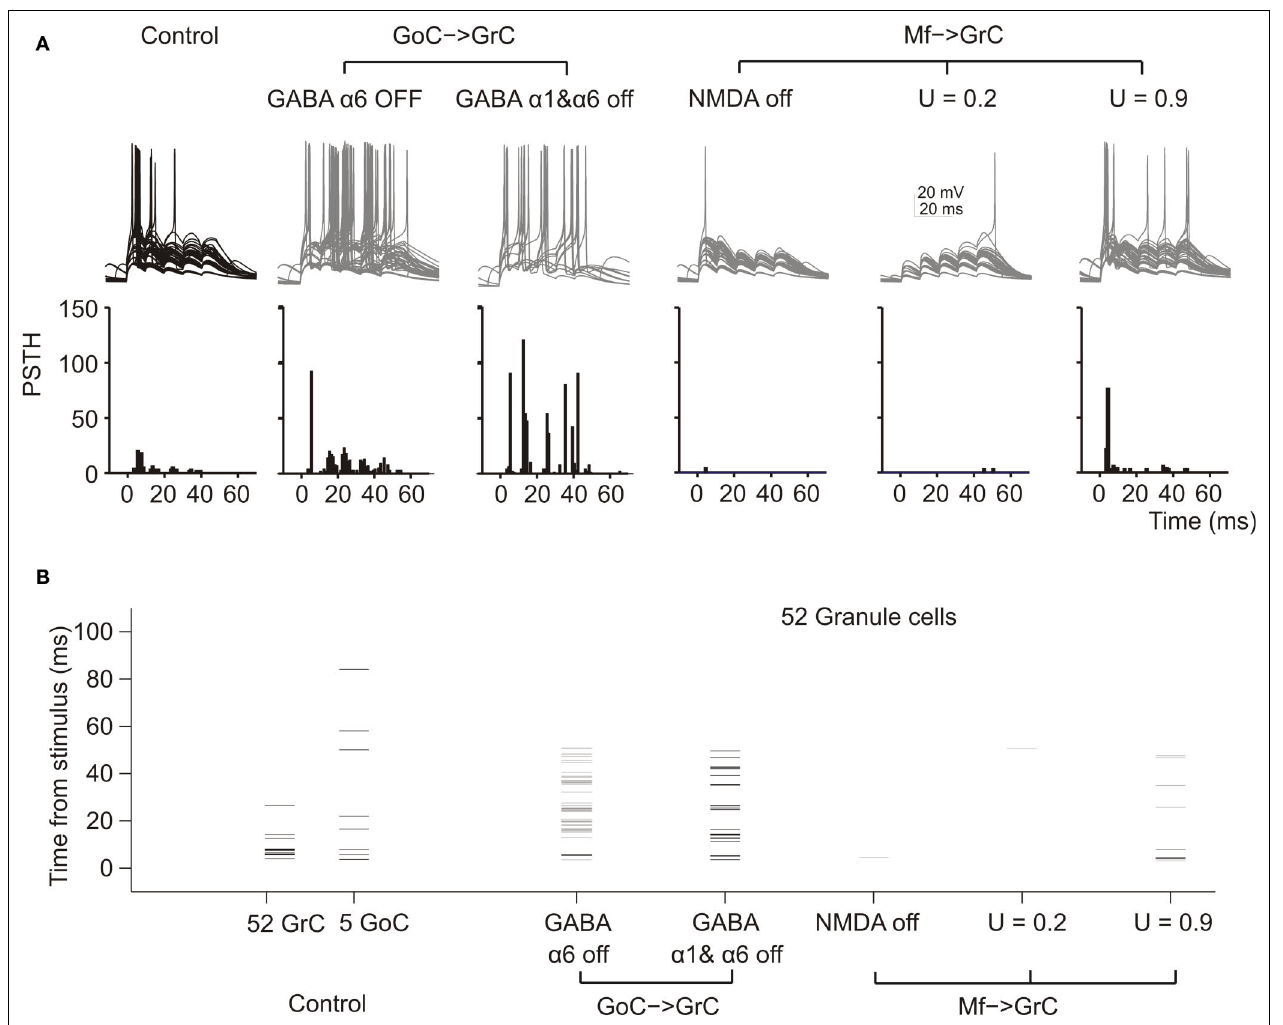
FIGURE 4 | The impact of molecular/cellular mechanisms on GrC synaptic excitation in the network. (A) Response of GrCs activated by a mf burst (fi ve spikes at 100 Hz on eight contiguous mfs). Each group of traces corresponds to the same 52 GrCs sharing a common bursting mf. The underlying PSTH reports the probability of spike occurrence in 1-ms bins for all (250) GrCs responding to the mf burst. Note that the switch-off of GABA-A α 6 receptors and even more of GABA-A α 1 + GABA-A α 6 receptors, which control the fast and slow components of inhibition, considerably enhances spike generation protracting the duration of the output burst. Blocking the NMDA receptors prevents EPSP